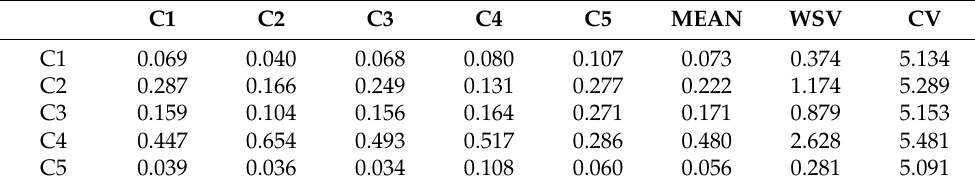
Table 4. Normalized matrix for the